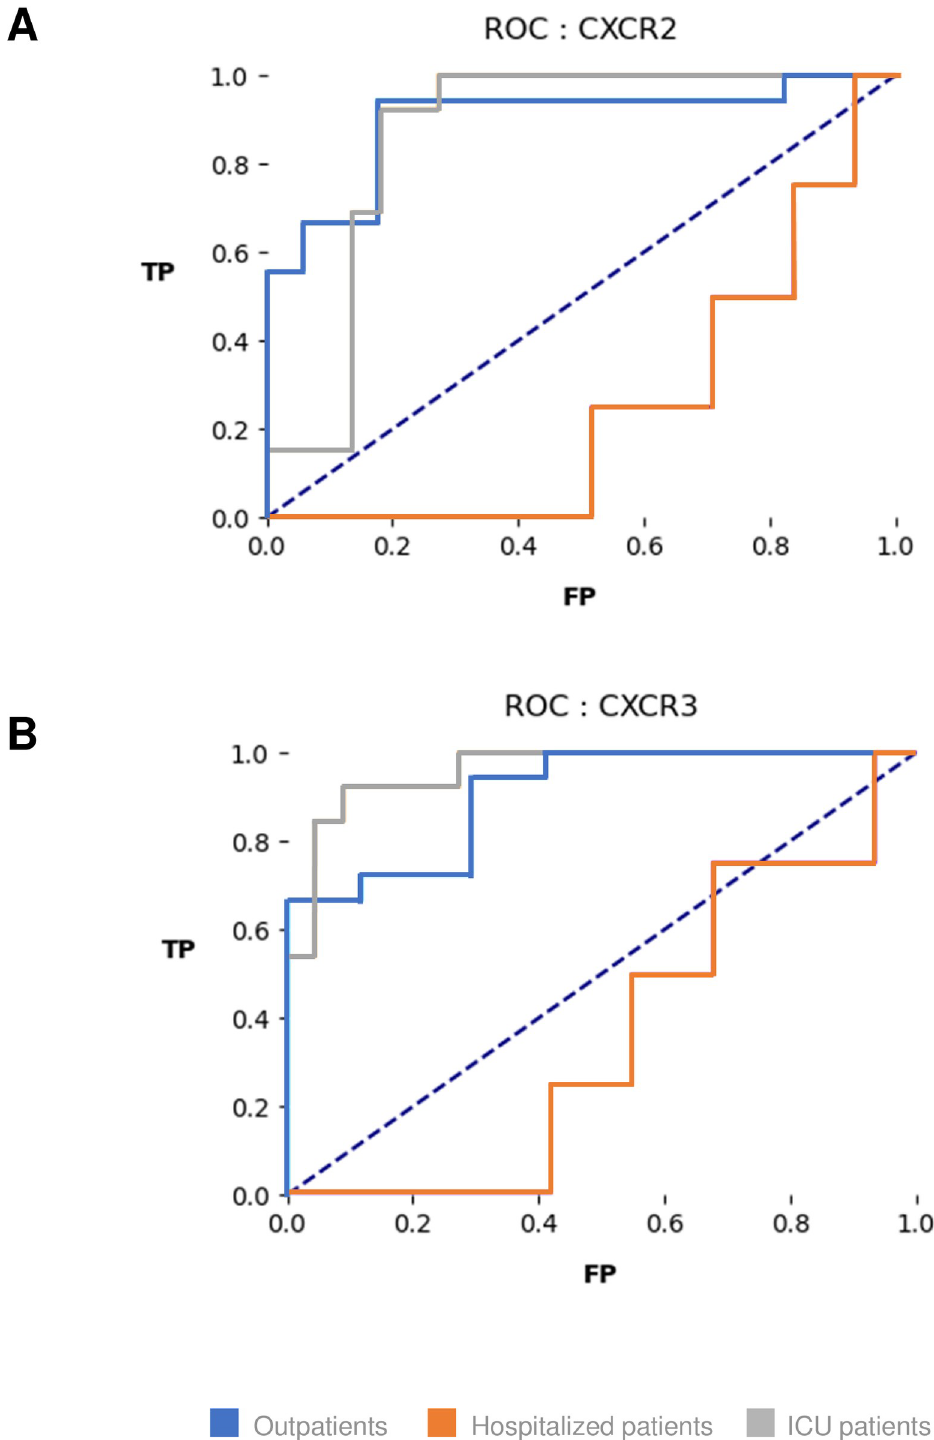
Fig 4. Receiver operating characteristic (ROC) curves of CXCR2 (A) and CXCR3 (B) panel predictive values on the severity of COVID-19 disease. The CXCR2 panel included normalized transcript counts for CXCL1, IL8, CXCL5 and CXCR2. The CXCR3 panel included normalized transcript counts for CXCL10, CXCL11, CXCL9, CXCR3, GZMB, CCR6 and CCL20. TP: true positive; FP: false positive.